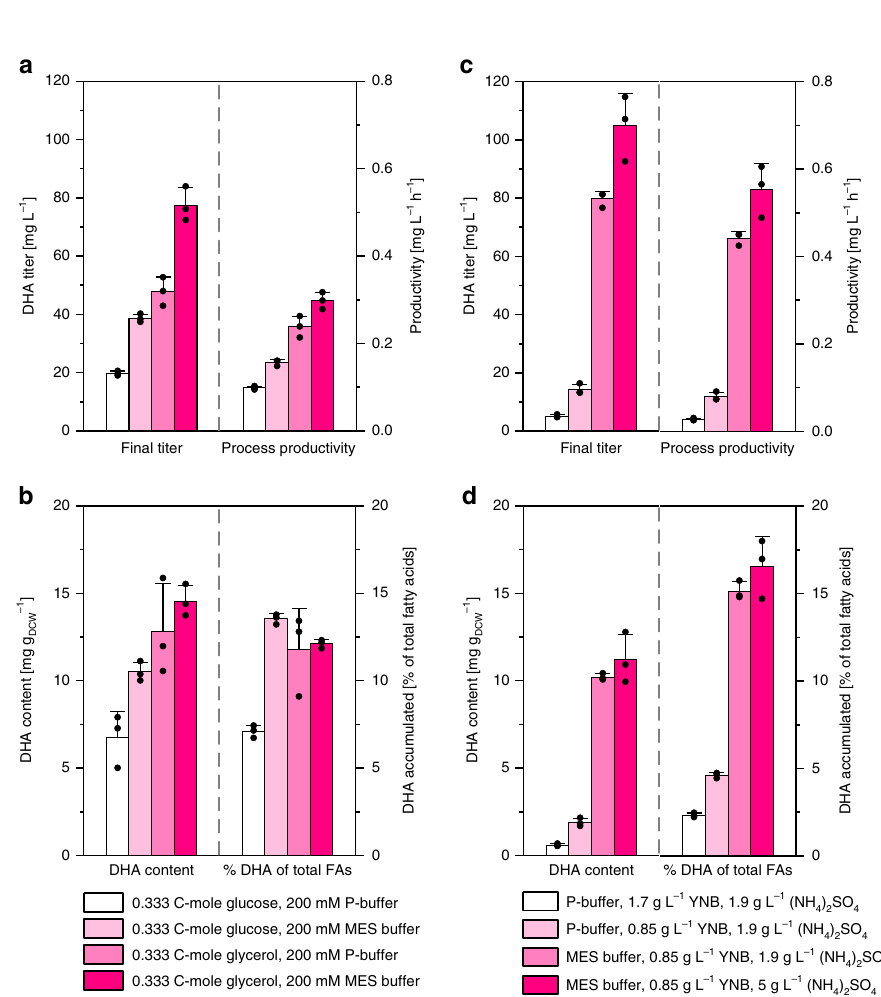
Fig. 4 DHA production improvement in Y. lipolytica Po1h::Af4 based on an optimization of medium composition. Shake fl ask cultivations were carried out in triplicates. Performance parameters were determined after 200 h of cultivation. Graphs show means and s.d. Source data are provided as a Source Data fi